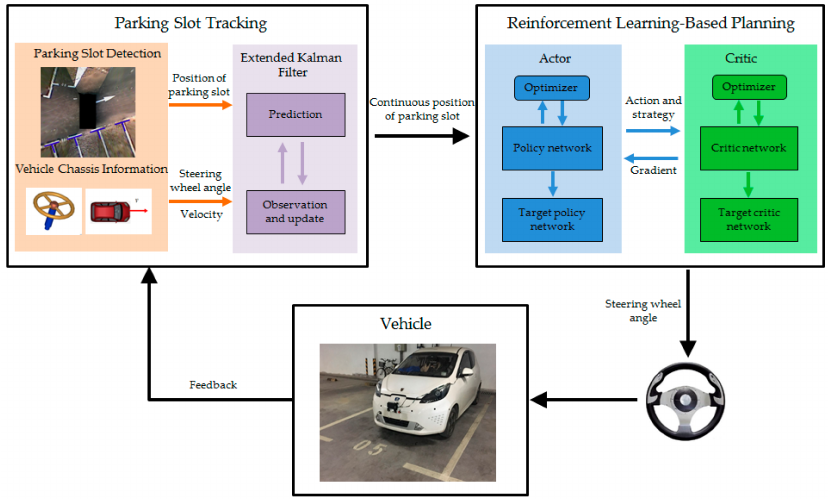
Figure 25. Overview of the reinforcement learning-based end-too-end parking method presented in